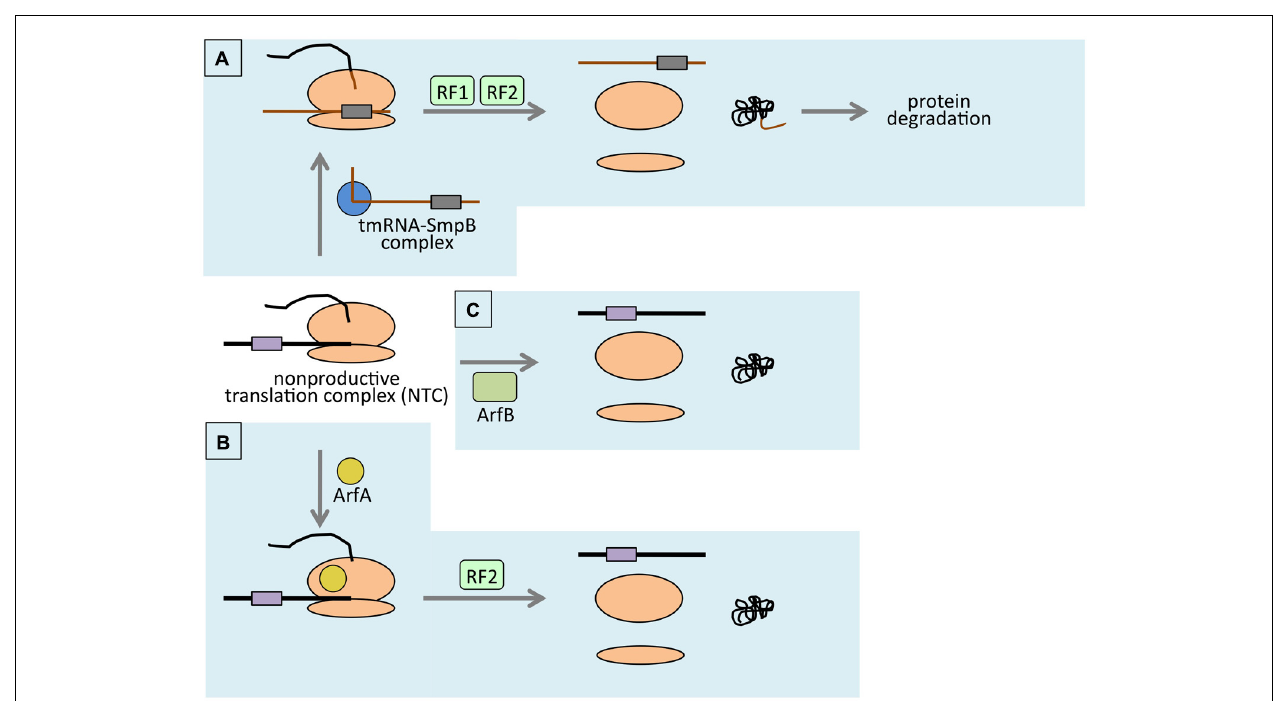
in brown) attached to the C-terminus. (B) ArfA-mediated ribosome rescue. RF2 is indispensable in this pathway. tRNA enhances this reaction by unknown mechanism. (C) ArfB-mediated ribosome rescue. As a stop codon-independent RF homolog, ArfB binds to A-site of the ribosome within NTC and hydrolyzes peptidyl-tRNA. Only the relevant factors are